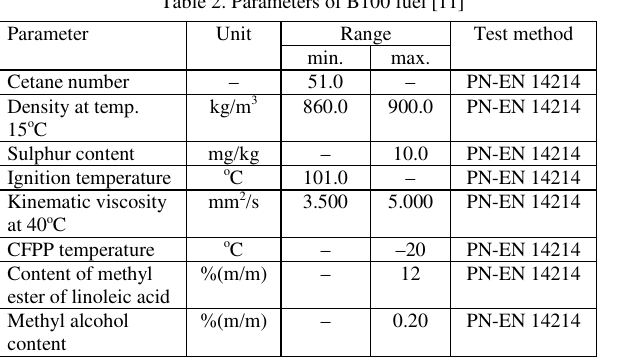
Table 2. Parameters of B100 fuel [11]